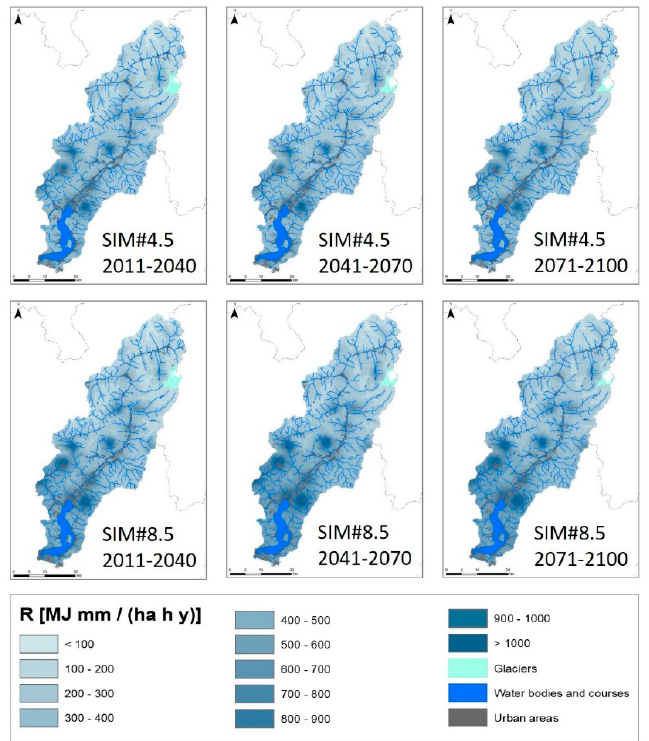
Figure 8. R-factor simulated with SIM#4.5 (first row) and SIM#8.5 (second row) at 2011–2040 (first column), at 2041–2070 (second column), and at 2071–2100 (third column).